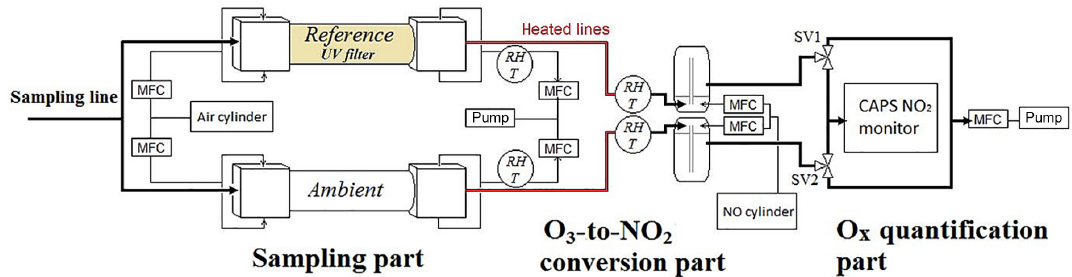
Figure 1. Schematic of the OPR instrument. O 3 converted into NO 2 by reaction with NO. Difference in O x mixing ratios between the two flow tubes quantified by CAPS. SV: solenoid valves. MFC: mass flow